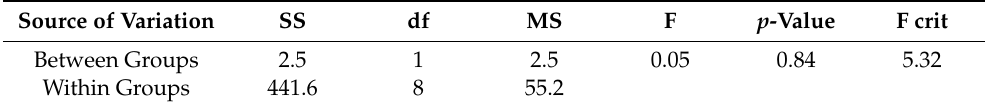
Table 2. ANOVA-Single Factor two samples of unequal variances in the ages in both ICUs.